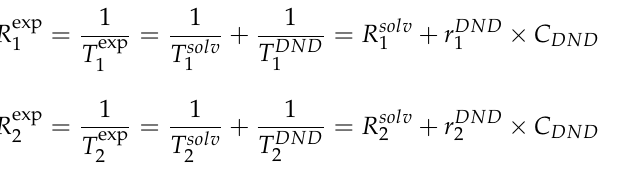
Figure 2. Dependence of the spin – spin relaxation rate R 2 (circles) [16] and the spin – spin relaxation time T 2 (triangles) of water protons in aqueous DND suspensions on the DND concentration. This experimental result contrasts with the linear concentration dependence of T 1 and T 2 reported by Sękowska et al. , [21]. The latter is inconsistent with that published in the literature and the fundamentals of the relaxation phenomena in nuclear spin systems, which casts some doubt on the correctness of the measurements and conclusions made in Ref. [21]. Herewith, we note that the measurements of Sekowska et al., particularly those of T 2 , were carried out in a limited range of nanodiamond concentrations, which causes some difficulties in establishing the character of the concentration dependence measured by these authors. Similar dependencies were obtained for suspensions of the gadolinium-grafted DND (Gd-DND), which are shown in Figures 3 and 4. Contributions of paramagnetic gadolinium ions grafted to the DND surface to the spin – lattice and spin – spin relaxations of water protons in this case are: